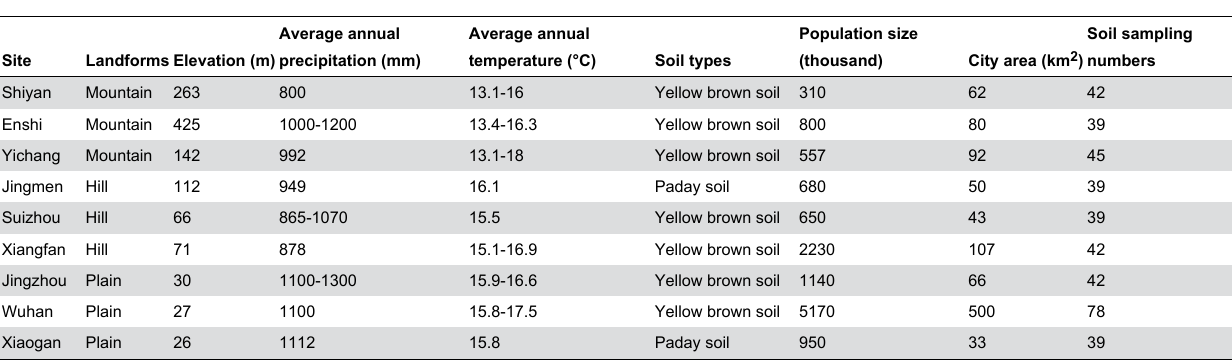
Table 1. Descriptions of the nine study cities